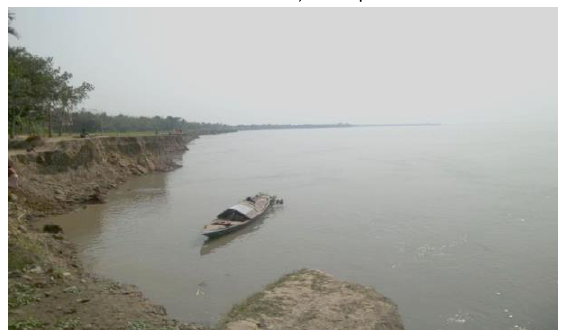
Figure 10. Bank erosion 6 km south from